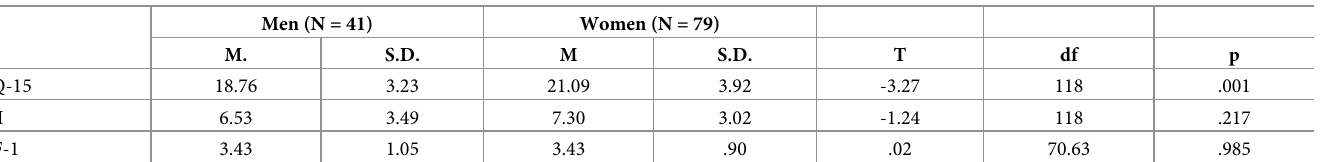
Table 3. Results from the independent-samples t-tests.